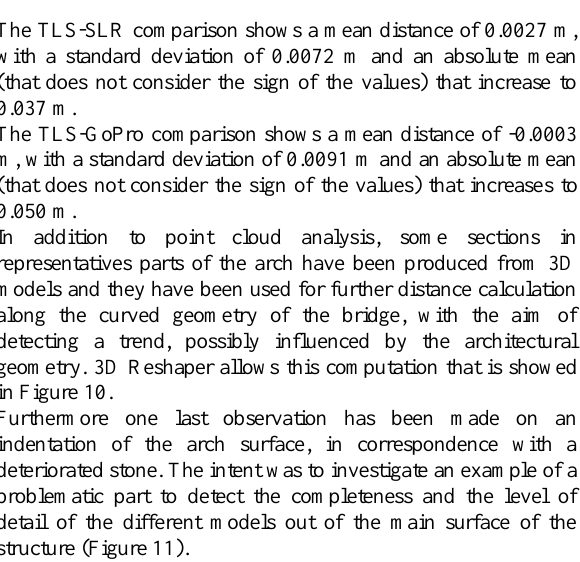
Table 4. Basic statistics about M3C2 distance data from TLS- SLR analysis.